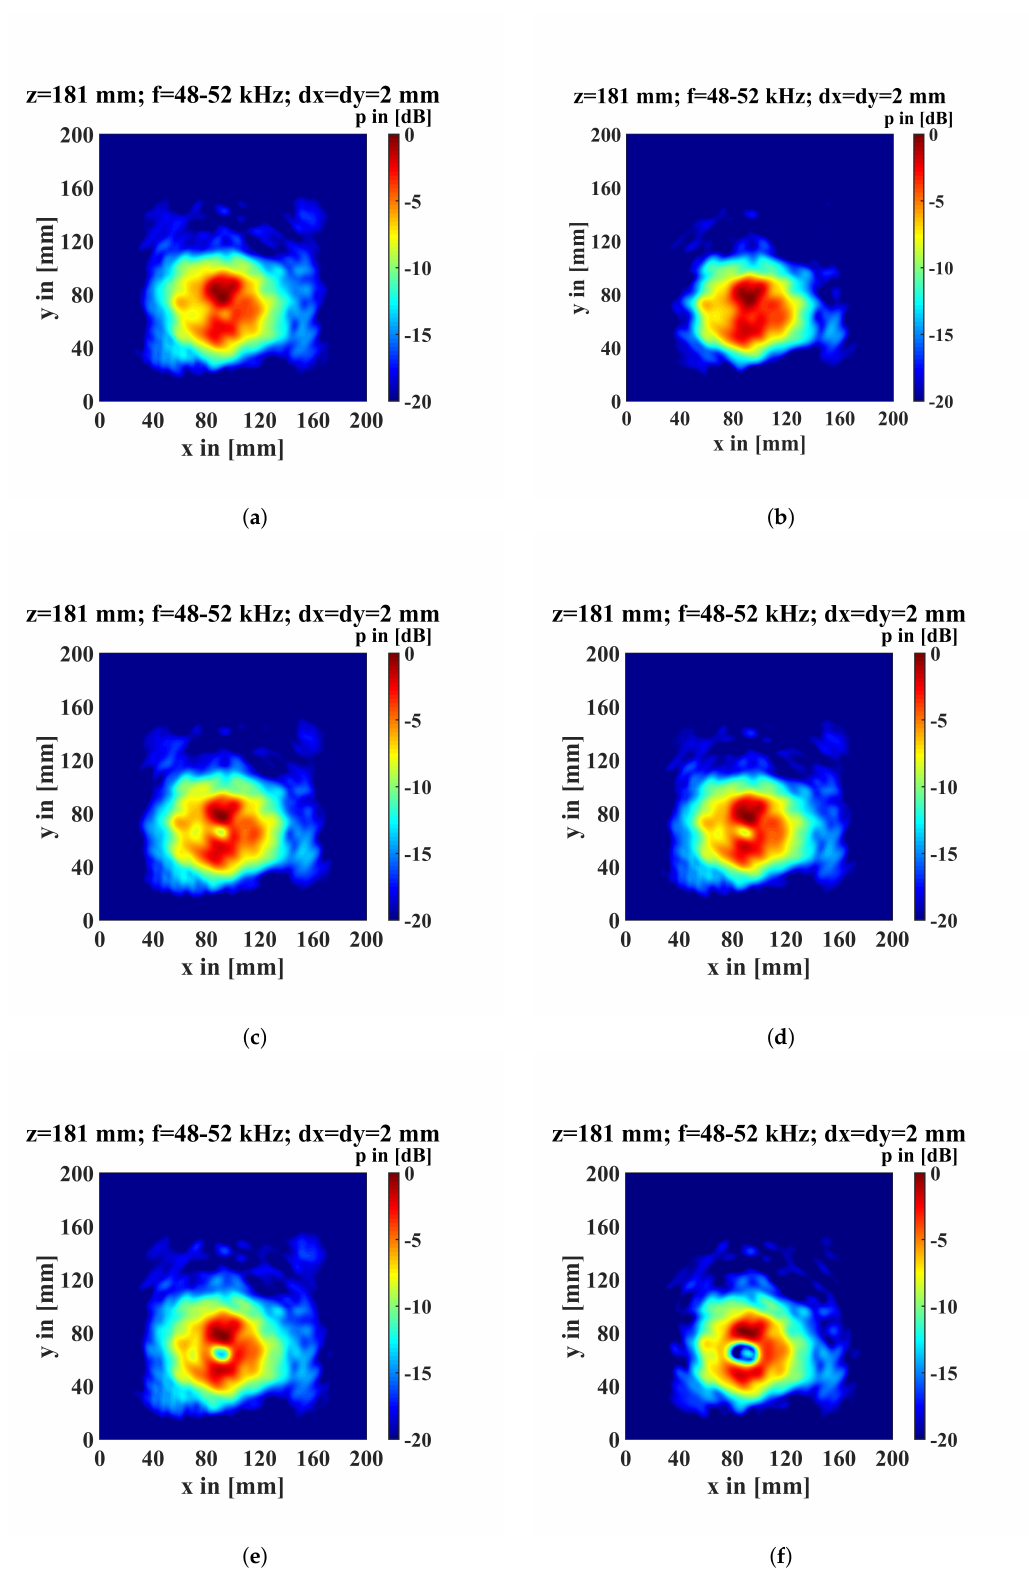
Figure 6. Back propagated amplitudes at the top of the particleboard. ( a ) Without a flaw, ( b ) with a 2 mm flaw, ( c ) with a 4 mm flaw, ( d ) with a 5 mm flaw, ( e ) with a 10 mm flaw, and ( f ) with a 20 mm